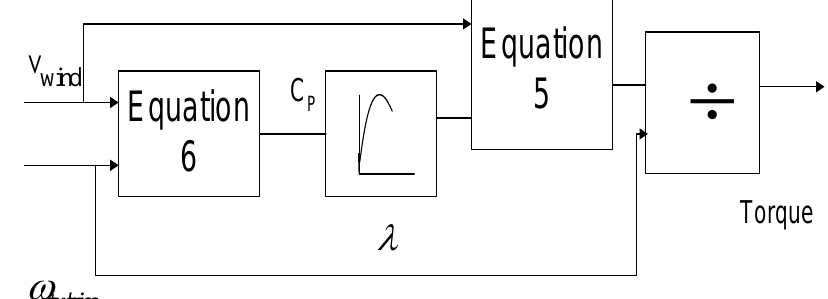
Figure 3. “Model of Wind